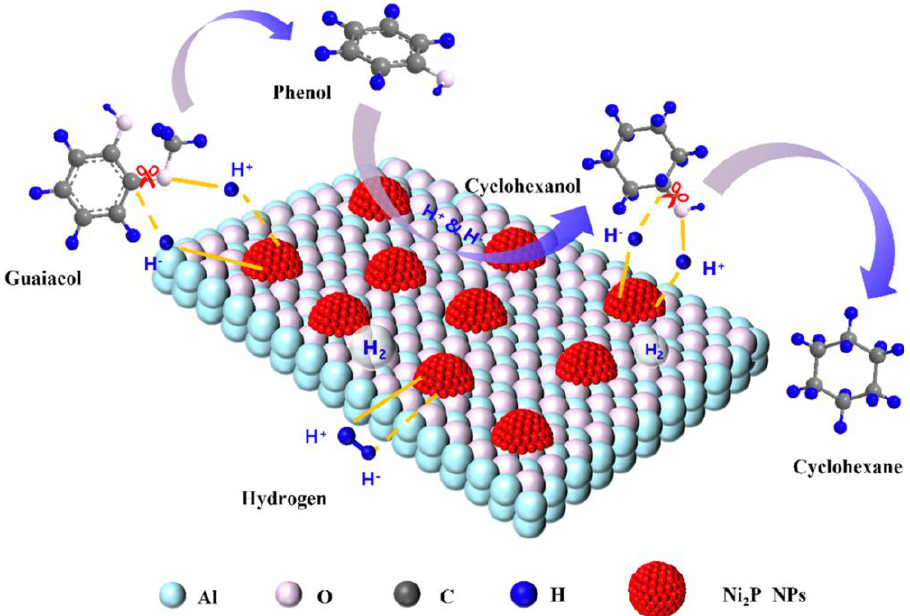
Figure 3. Reaction mechanism of guaiacol hydrodeoxygenation over NiP catalysts [158]. (Copyright 2022, American Chemical Society).